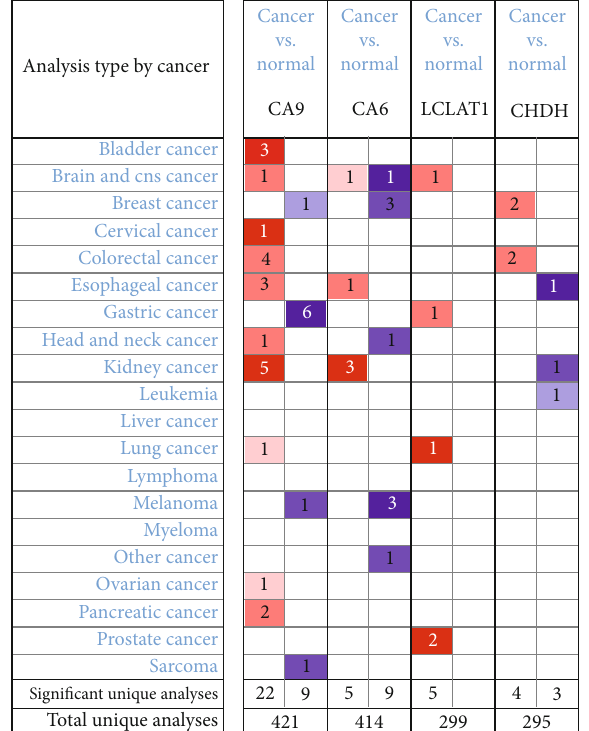
Figure 8: The transcriptional levels of CA6 , CA9 , LCLAT1 , and CHDH in cancers and normal samples. Redder means higher expression and bluer means lower expression. (ONCOMINE